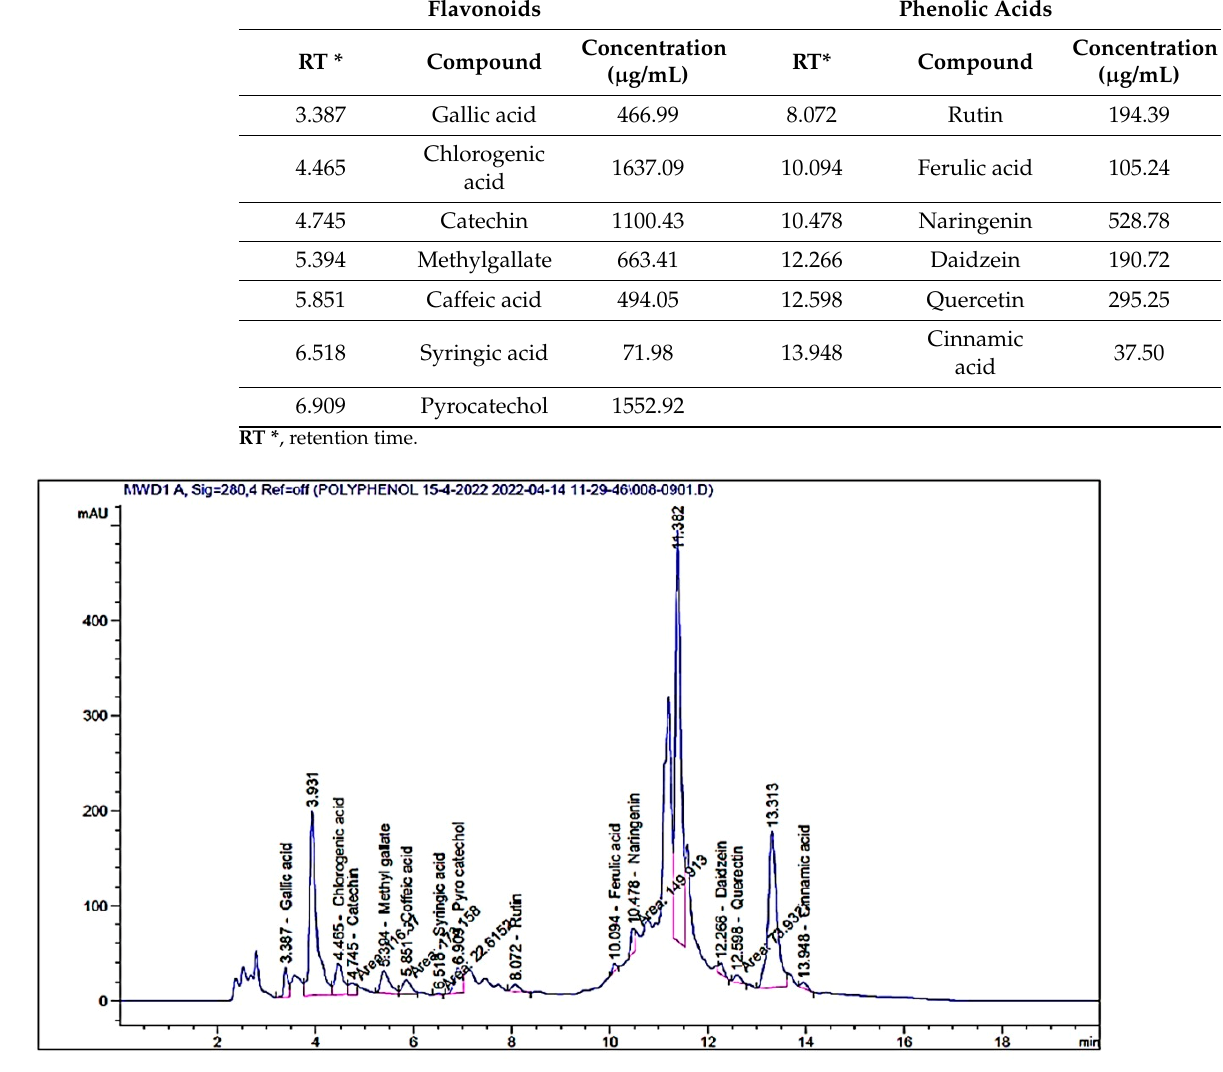
Figure 2. HPLC chromatograms of detected flavonoids and phenolic acids content of A. vera gel